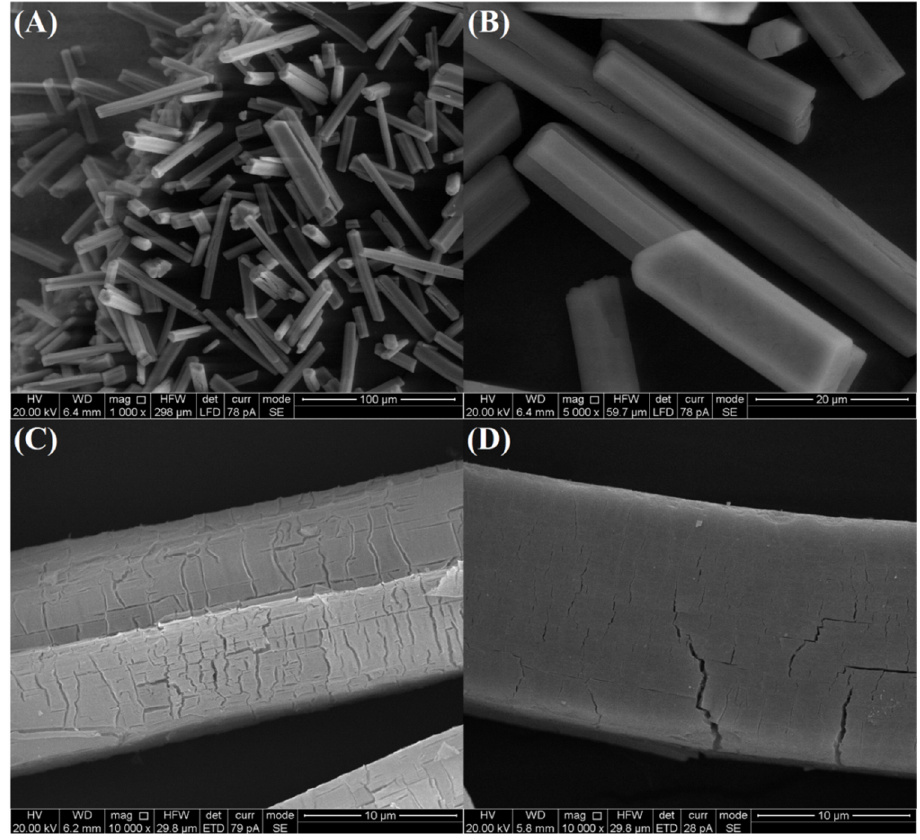
Figure 1. SEM images of ( A , B ) as-synthesized Ce-BTC, ( C ) CeO 2 (Air) and ( D ) CeO 2 (N 2 -Air).